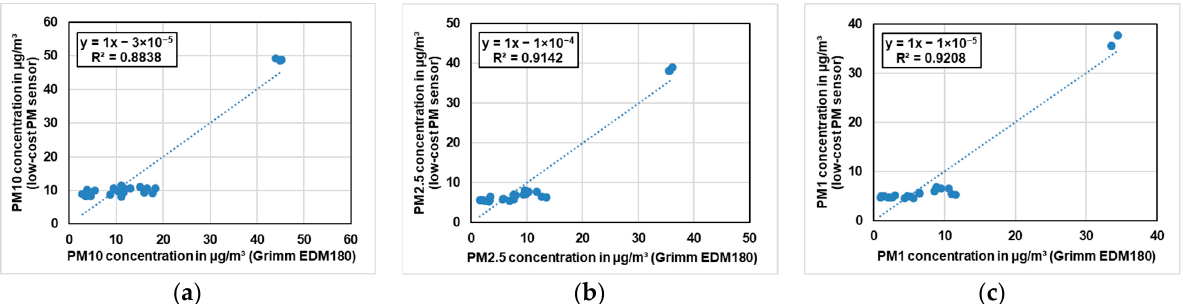
Figure 17. ( a ) PM10, ( b ) PM2.5 and ( c ) PM1 comparison of low-cost PM sensor with Grimm EDM180 during the whole campaign at Marienplatz for the period with relative humidity below 70%.